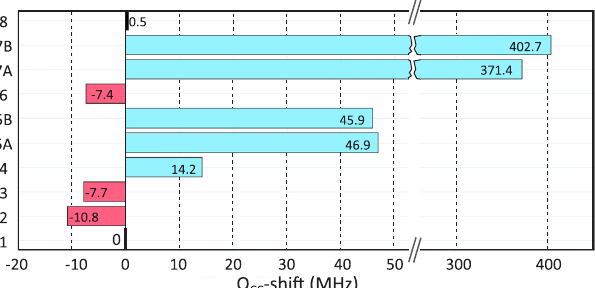
FIG. 5. Q cc shifts of Bi-aryl compounds with respect to triphenylbismuth (1) at 37 °C ( Q cc ¼ 668 . 3 MHz), depending on the ligand type, according to Fig.